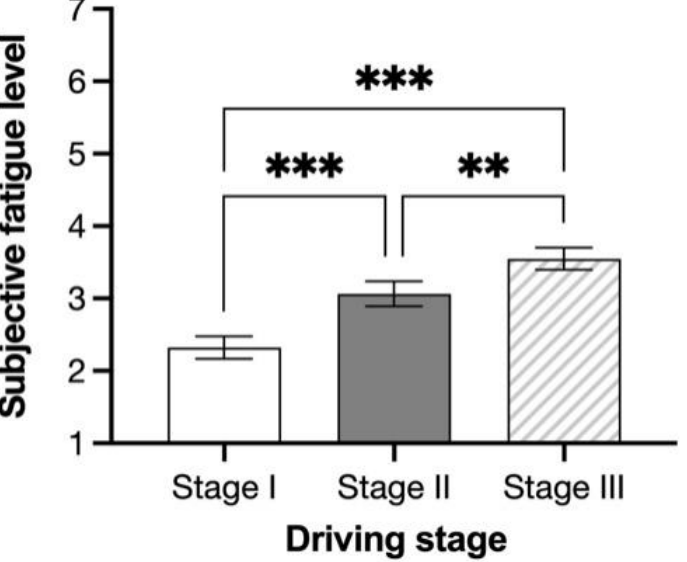
Table 4. Overview changes of eye movement and driving performance caused by passive fatigue in different driving stages [ M ( SD )].